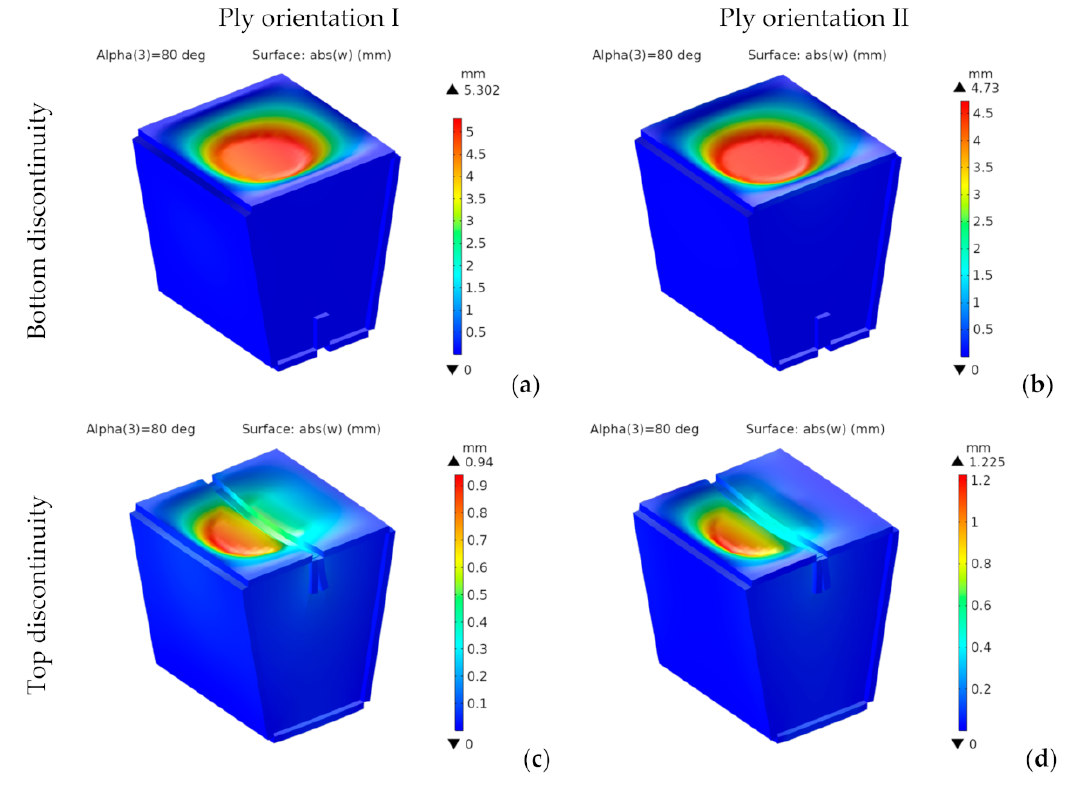
Figure 18. 1st design. Vertical deflection [mm] for bottom ( a , b ) and top ( c , d ) discontinuity. For the designs with bottom discontinuity, the vertical deflections show a revolution geometry about the vertical axis, with a flat bottom. Their maximum values for top discontinuity are located on the seating surface panel closest to the load application